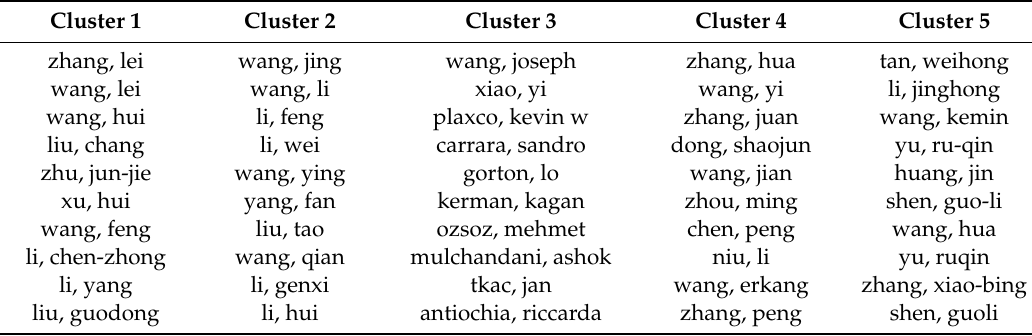
Table 3. List of top ten authors in the first five co-authorship